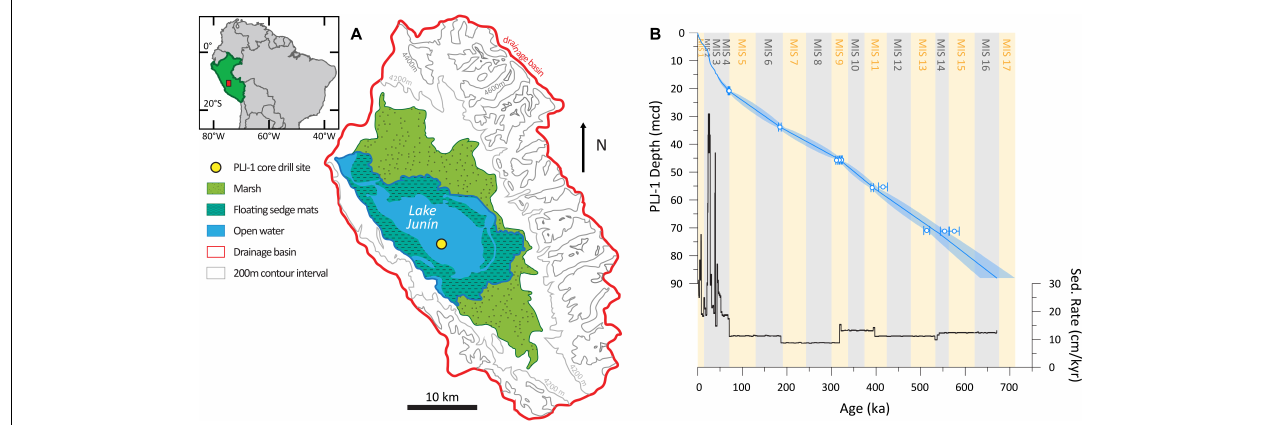
FIGURE 1 | (A) Location of the Lake Junín drainage basin and the position of the PLJ-1 ICDP drill site (yellow circle), and (B) existing Bacon -derived radiometric-based age-depth model (blue line) based on 79 radiocarbon dates and 18 U-Th age constraints for the Lake Junin splice (Woods et al., 2019; Chen et al., 2020) with 2-sigma uncertainty (blue shading) and calculated mean sedimentation rate (black line). The 79 radiocarbon and 6 U-Th age constraints from the last 50 kyrs are not shown on the age-depth plot for clarity. Marine Isotope Stages (MIS) are indicated with glaciations shaded gray and interglaciations shaded yellow as defined in LR04 (Lisiecki and Raymo,